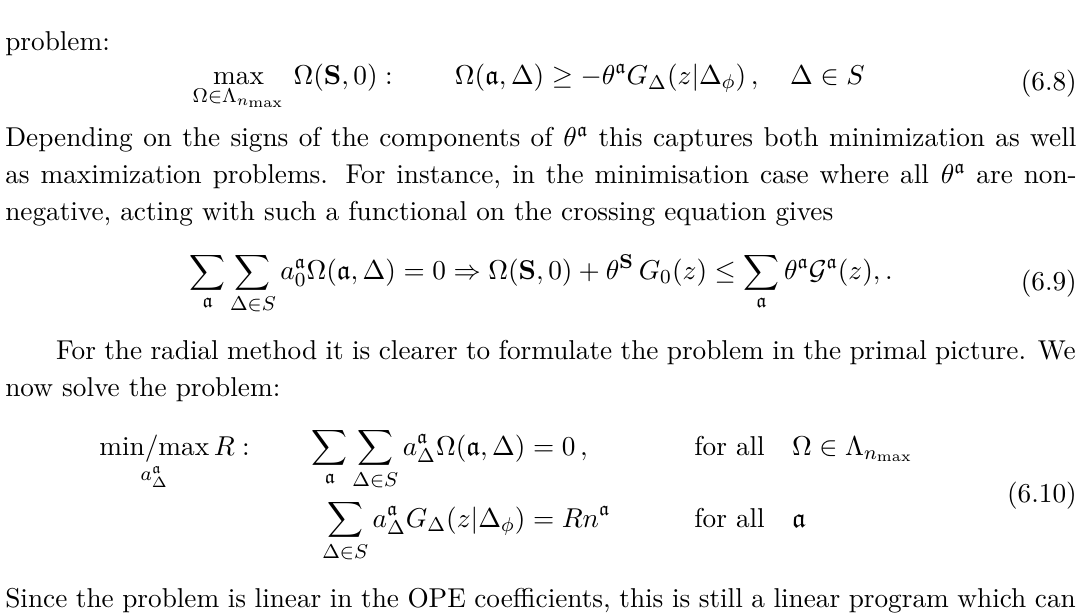
Figure 6 . Bounds on O ( N ) correlators at the crossing symmetric point z = 1 / 2 and ∆ φ = 1 . √ We present results in terms of ˆ G a ( z ) := z 2∆ φ G a ( z ) / d . On the left bounds for various values of a N , on the right for N = 2 . The light shaded regions represent the trivial constraints ˆ G a ≥ δ a S . The colored marked points on the right represent special solutions to crossing, with GFF and GFB (violet) the O(2) generalized free fermion/boson. Other points are explained in the main